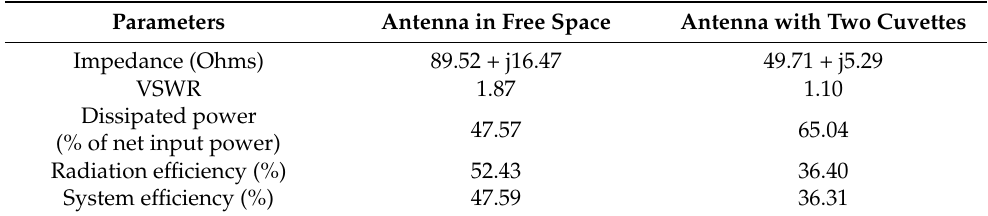
Table 2. Comparison of the FDTD-computed antenna parameters at 2.41 GHz, in two scenarios: antenna in the free space, and antenna with two cuvettes filled with erythrocyte suspension. Parameters Antenna in Free Space Antenna with Two Cuvettes Impedance